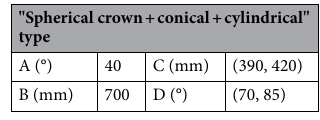
Table 8. Basic parameter setting.